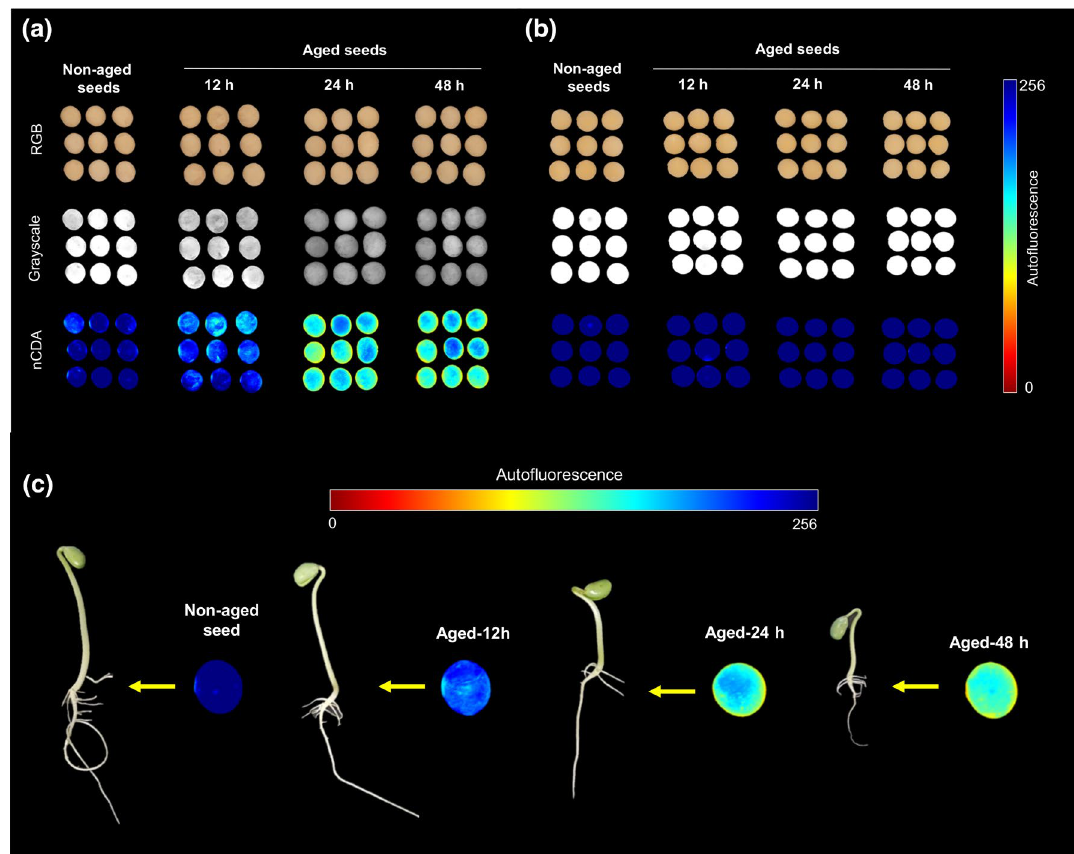
Figure 4. Raw RGB images from soybean seeds for classes of non-aged seeds and seeds aged for 12, 24 and 48 h, and corresponding autofluorescence images (grayscale and nCDA) captured at 365/400 nm excitation- emission combination, showing autofluorescence patterns in the presence (a) and absence (b) of the seed coat. Germination test at 8 days after sowing using seeds with different autofluorescence patterns in the nCDA images (c) . In the nCDA images, the pixel values (autofluorescence intensity) is calculated based on 10% trimmed mean to provide a more realistic